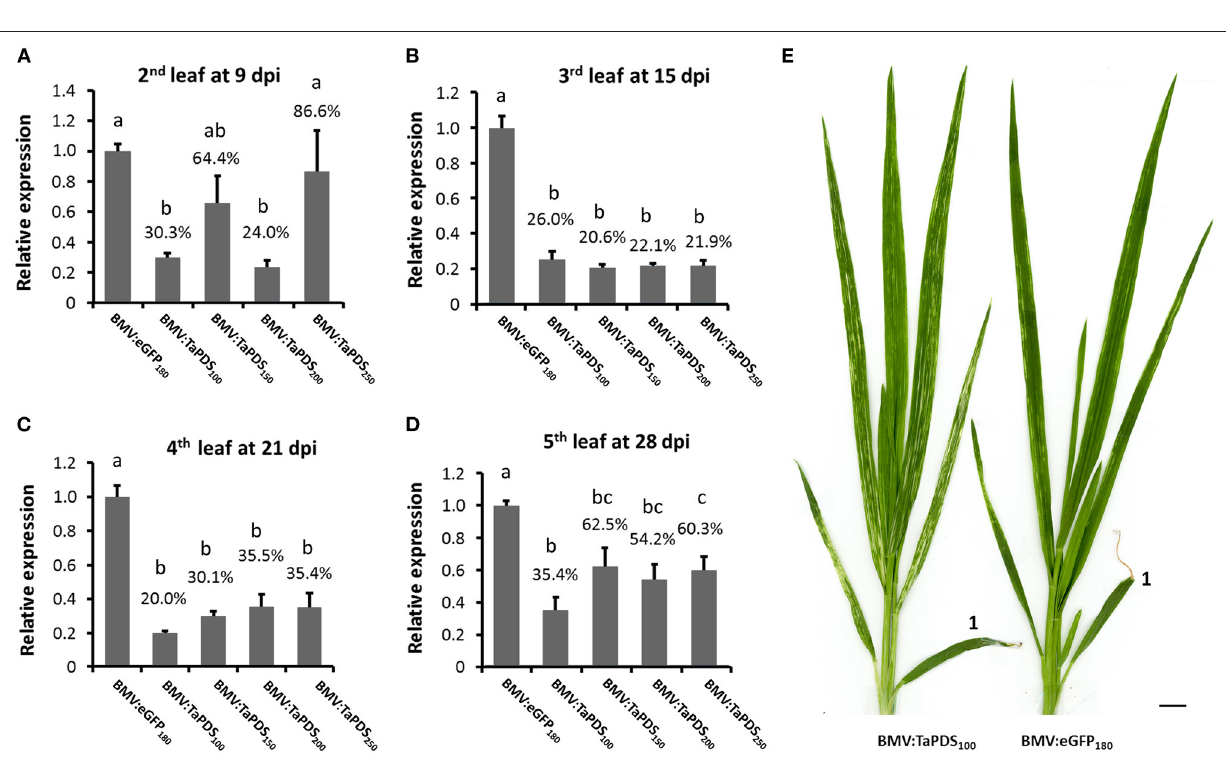
FIGURE 3 | Time-course analysis of BMVCP5-mediated silencing of TaPDS in wheat leaves. (A–D) Groups of five wheat plants were inoculated with BMVCP5 containing TaPDS fragments of 100, 150, 200, or 250 nt, or a 180-nt eGFP fragment using the coleoptile inoculation method. Relative expression levels of TaPDS mRNA in various systemically-infected leaves at various dpi were determined by RT-qPCR with values across treatments normalized against relative TaEF1 α mRNA levels. Expression percentages are given relative to the BMV:eGFP 180 control. Values represent means + SE of five biological replicates for all treatments except BMV:TaPDS 150 , in which four biological replicates were used. Different letters denote significant difference between treatments ( P < 0.05, significant ANOVA followed by LSD analysis). (E) Plants infected by BMV:PDS 100 or BMV:eGFP 180 at 28 dpi. The first leaf above the inoculated coleoptile is marked with “1.” Bar = 1cm. A consistent bleaching phenotype and silencing of TaPDS transcripts were detected in the 2nd to 5th systemic leaves of wheat plants infected with BMV:PDS 100 . Similar results were obtained in two independent experiments. TABLE 1 | Comparison of the infection and silencing features of BMVCP5 containing different TaPDS inserts. VIGS